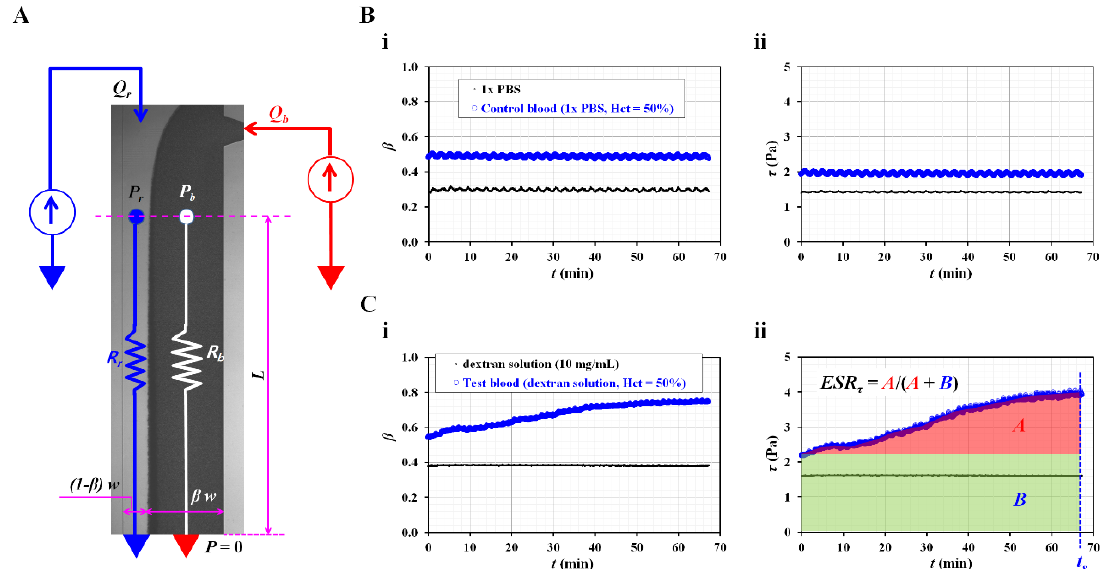
Figure 2. RBC sedimentation index in terms of shear stress of blood flow. ( A ) Discrete fluidic circuit model for estimating shear stress of blood flow in coflowing channel. ( B ) Variations of shear stress for control blood with no RBC sedimentation. In this case, control blood (hematocrit = 50%) was prepared by adding normal RBCs into 1× phosphate-buffered solution (PBS). ( i ) Temporal variations of interface ( β ) with respect to 1× PBS as well as control blood. ( ii ) Temporal variations of shear stress with respect to 1× PBS as well as control blood. ( C ) Variations of shear stress for sedimentation-enhanced test blood. Test blood (hematocrit = 50%) was prepared by adding normal RBCs into dextran solution (10 mg/mL). ( i ) Temporal variations of interface ( β ) with respect to dextran solution and test blood. ( ii ) Temporal variations of shear stress with respect to dextran solution and test blood. From the results, RBC sedimentation index was suggested as ESR τ = A /( A + B ). Based on the temporal variations of τ, A and B were calculated as A = (cid:82) t s ( τ ( t ) − τ ( t = 0 )) dt and B = (cid:82) t s τ ( t = 0 ) dt . By substituting Equation (3) into Equation (7), both fluid streams satisfied with the same shear stress condition (i.e., τ r = τ b = τ ). According to Equations (3) and (6),